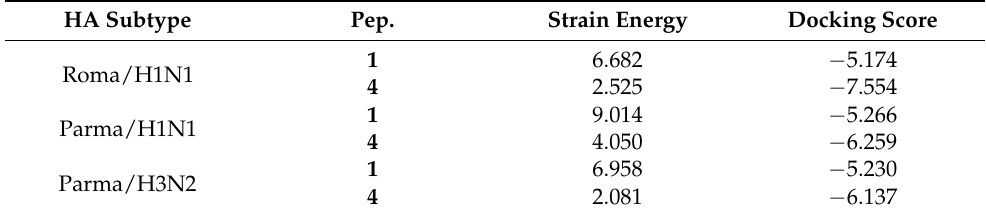
Table 3. Calculated strain energy and docking score of docked poses of peptides 1 and 4 in the studied HAs. These values are obtained running both a constrained and an unconstrained minimization with MacroModel. The energy difference is used to determine the strain energy. HA Subtype Pep. Strain Energy Docking Score